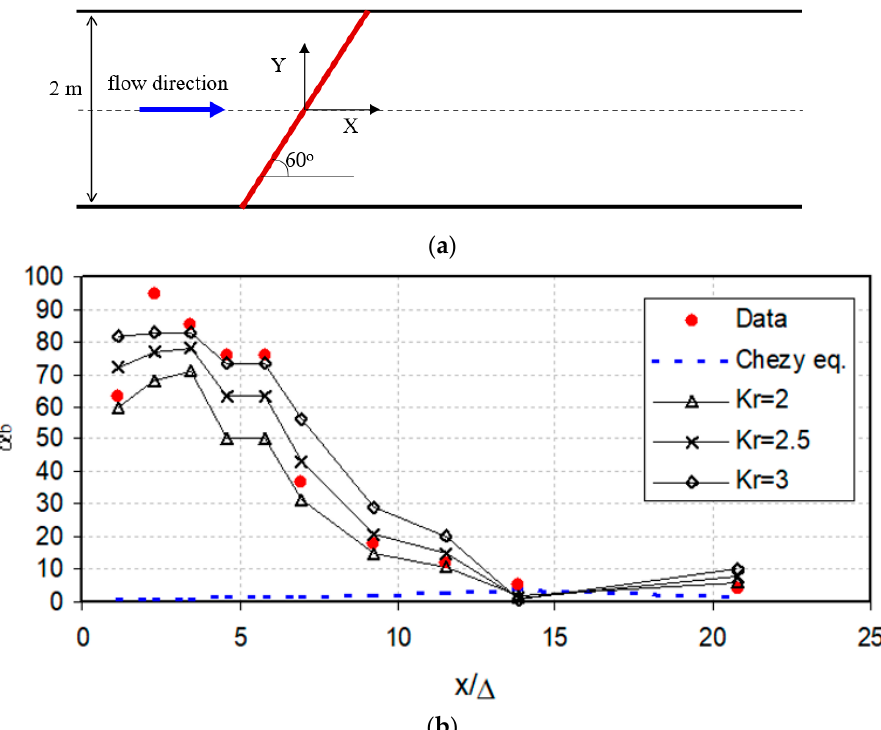
Figure 11. ( a ) Plan view of the oblique step experiment [33]. ( b ) Direction of the near-bed veloci- ties. Solid lines represent Equation (11). The dashed line represents the 2D version of the Chezy resistance formula.